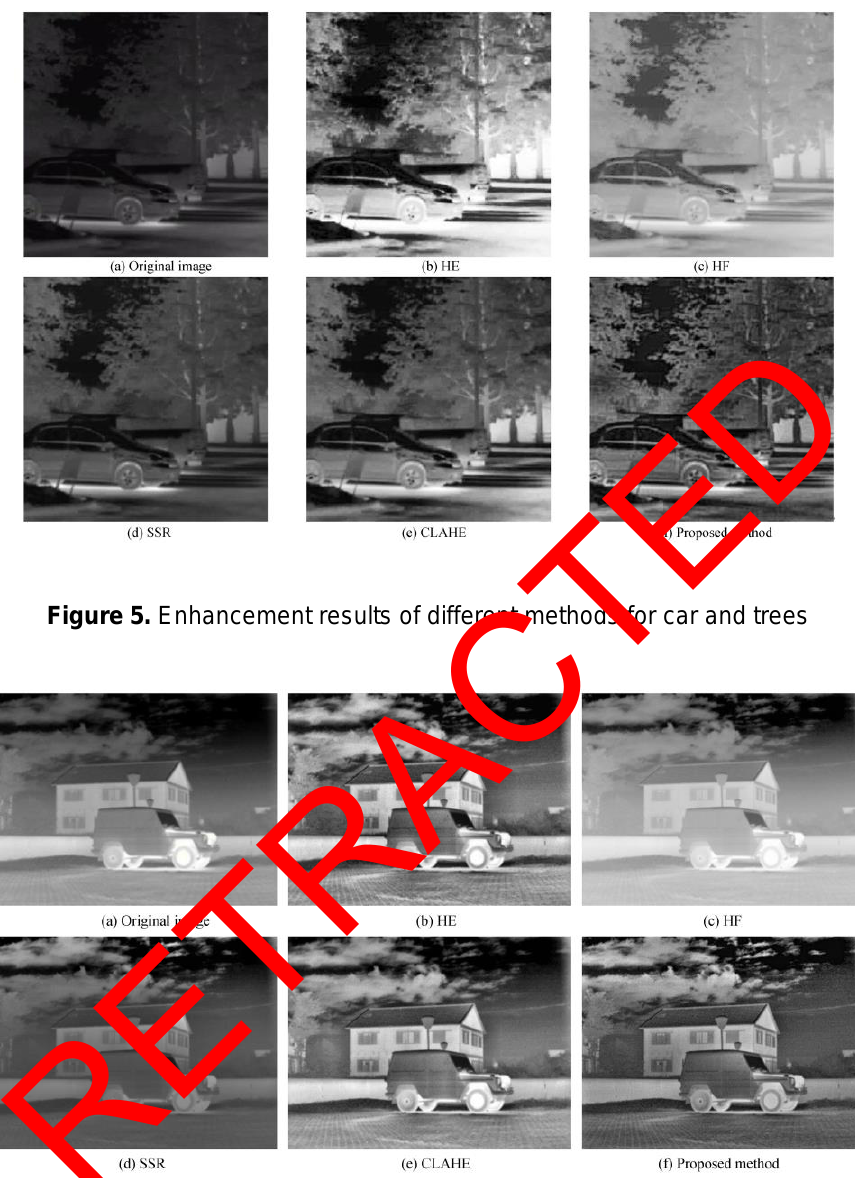
Figure 4. Enhancement results of different methods for infrared training figure